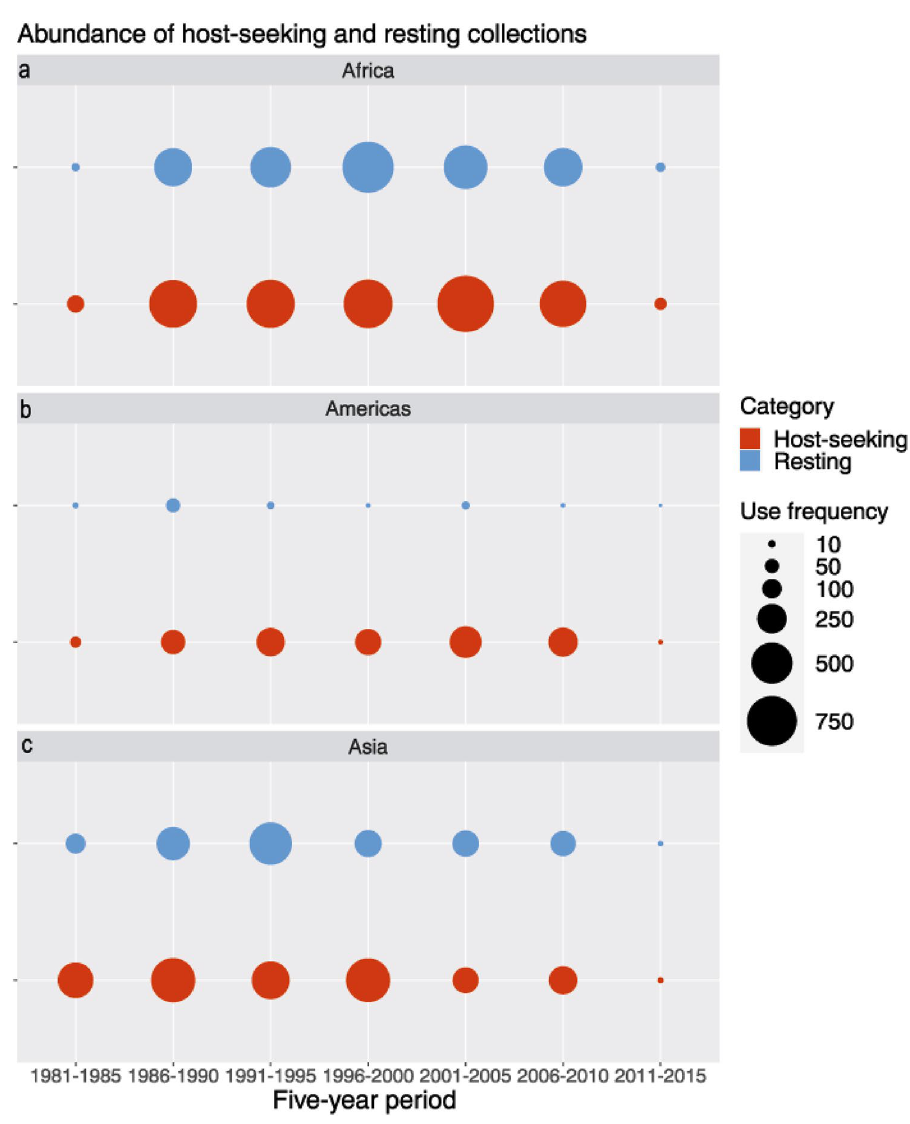
Figure 2. Number of data records. The number of data records for the two categories of collection methods, host-seeking and resting, presented per 5-year time period. ( a ) Africa, ( b ) Americas, ( c ) Asia-Pacific